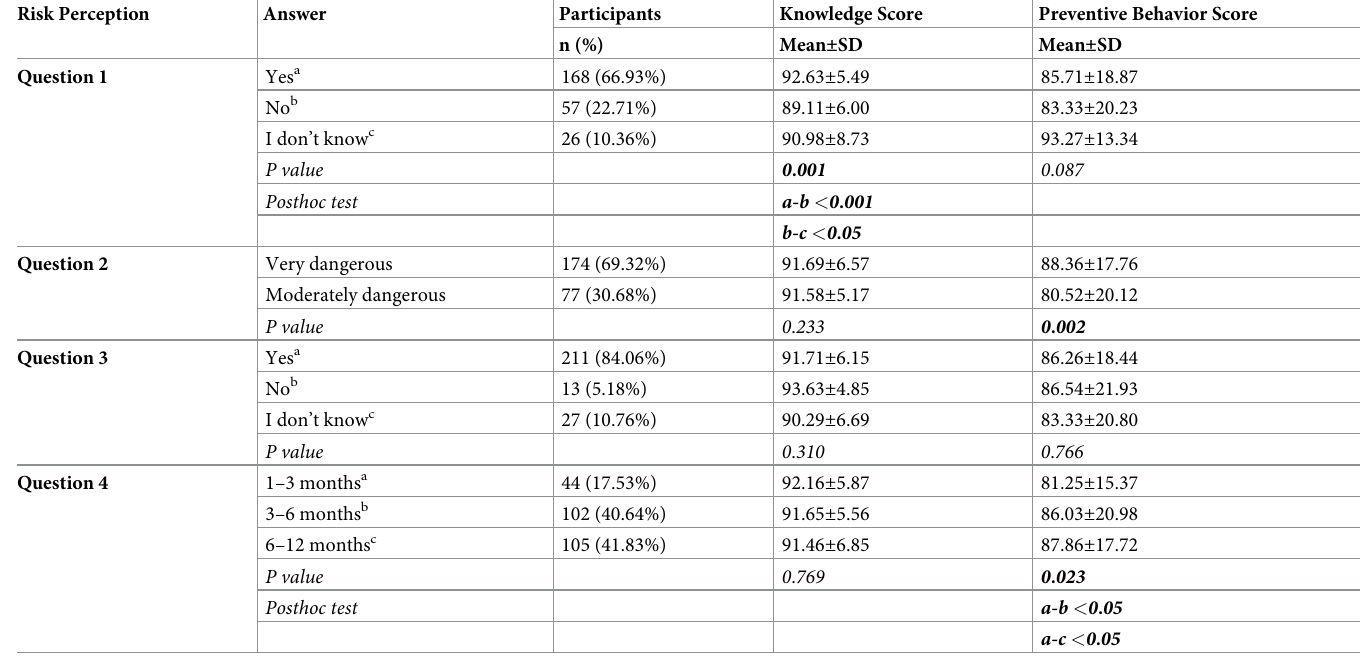
Table 3. Responses to the risk perception questions according to the percentage of correct answers to the knowledge-based and preventive behavior questions. Risk